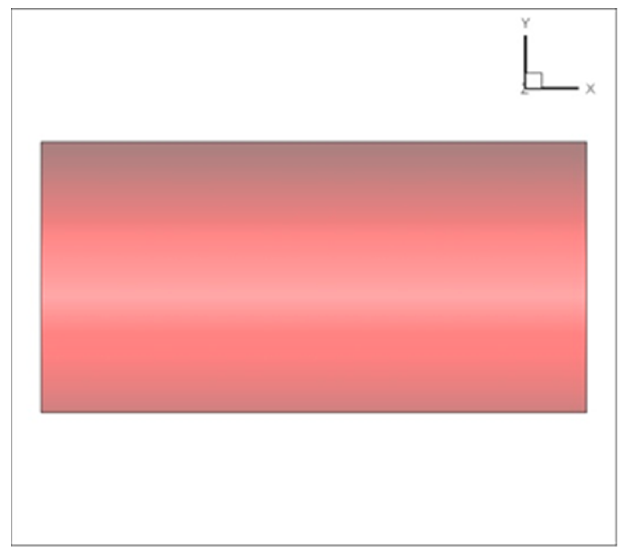
Figure 3. Pressure distribution without pressure pulse as inlet. After the simulation with pressure pulse is accomplished, the propagation process can be obtained as shown in Figure 4.